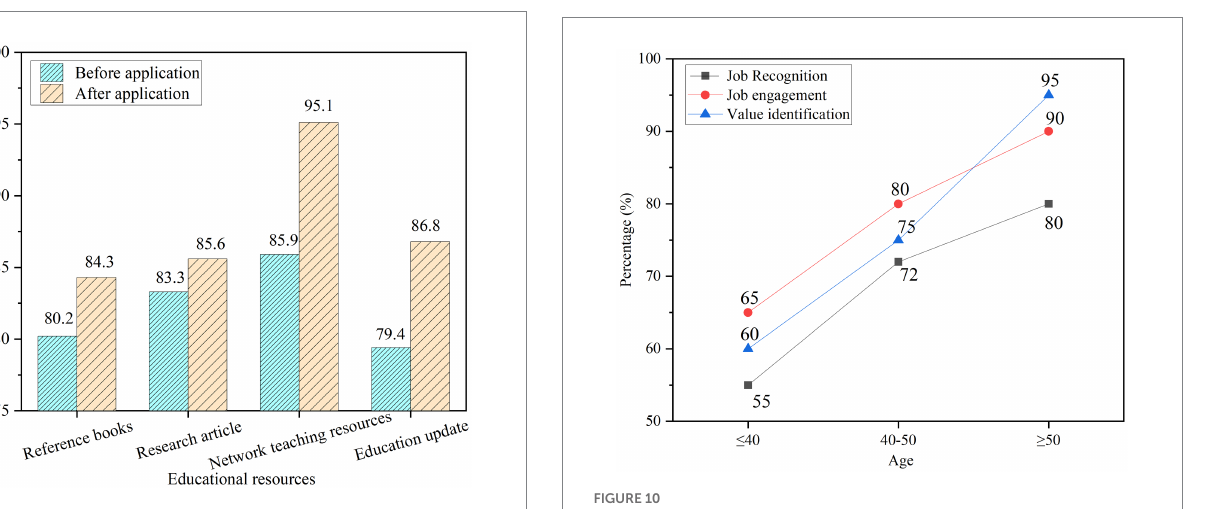
FIGURE 8 Comparison of educational resource recommendation results before and after model application.